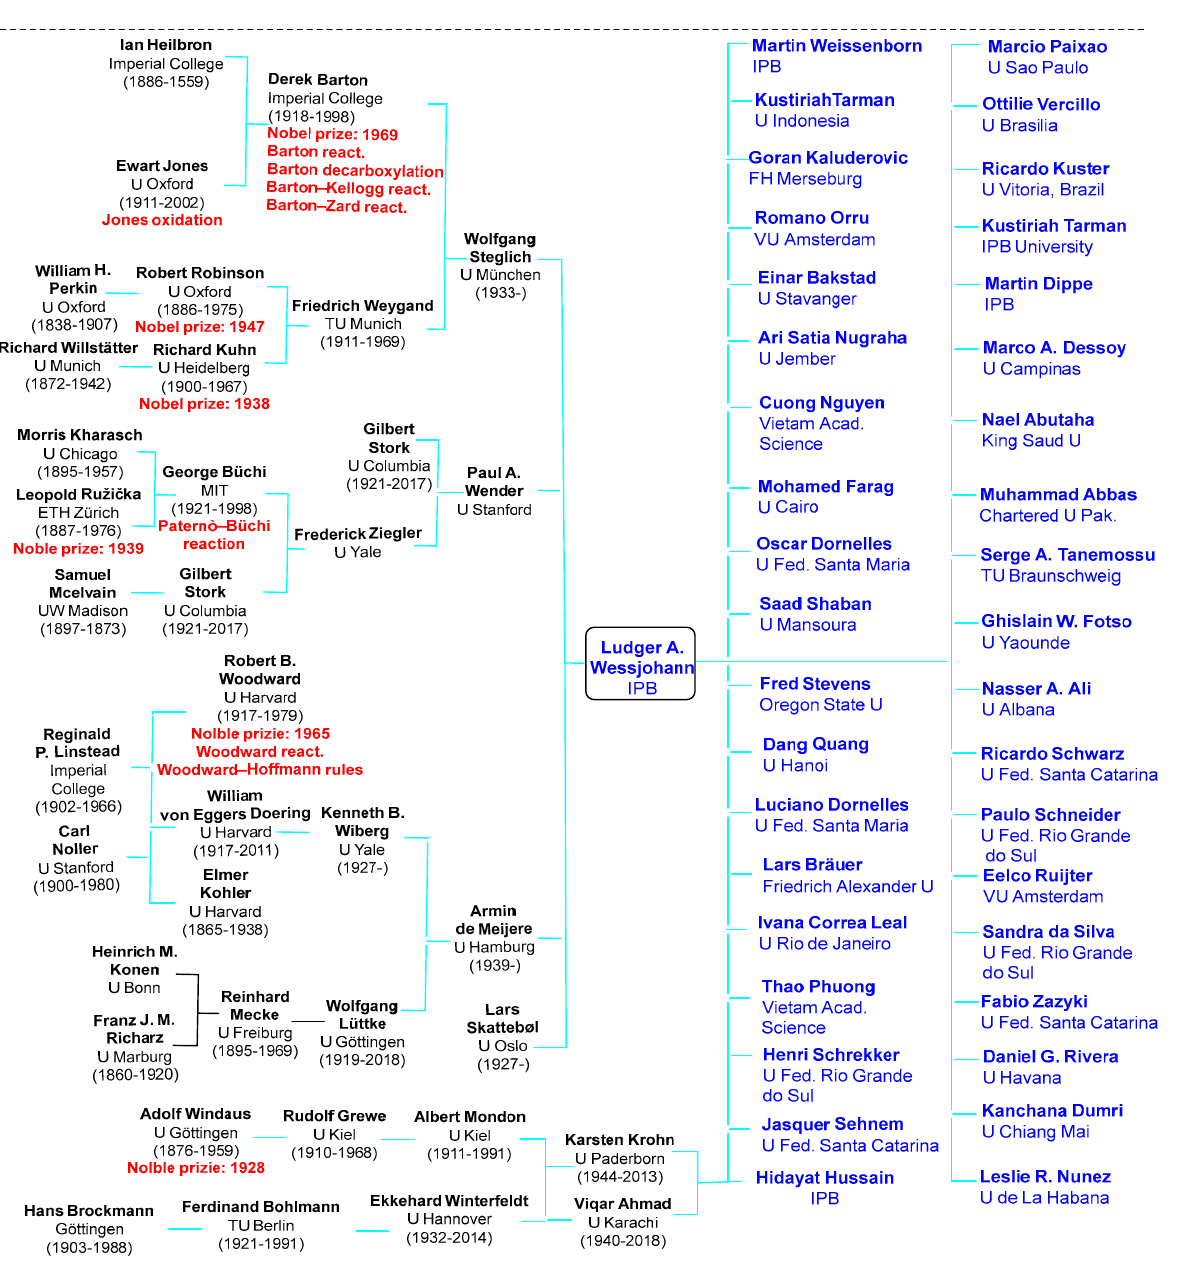
Figure 1. Ludger Wessjohann’s academic family tree; only some of the Ph.D. students and postdoc- toral fellows he has hosted and supervised and who eventually became university professors are considered; all researchers associated with him would exceed the limits of this compilation.